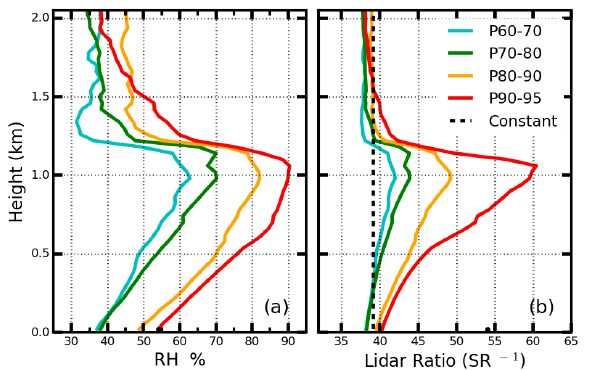
Figure 1. (a) Four kinds of RH profiles P60-70, P70-80, P80-90, and P90-95; (b) calculated LR profiles from the corresponding RH profiles of (a) . The dashed black line is one of the constant LR pro- files that are used to retrieve the MPL